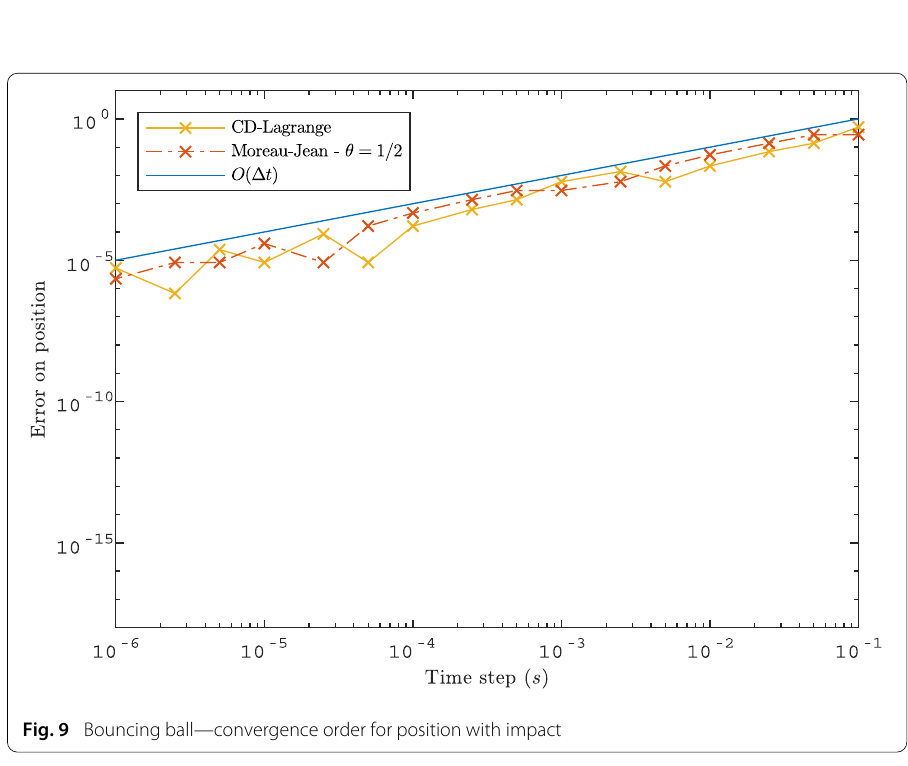
Fig. 9 Bouncing ball—convergence order for position with